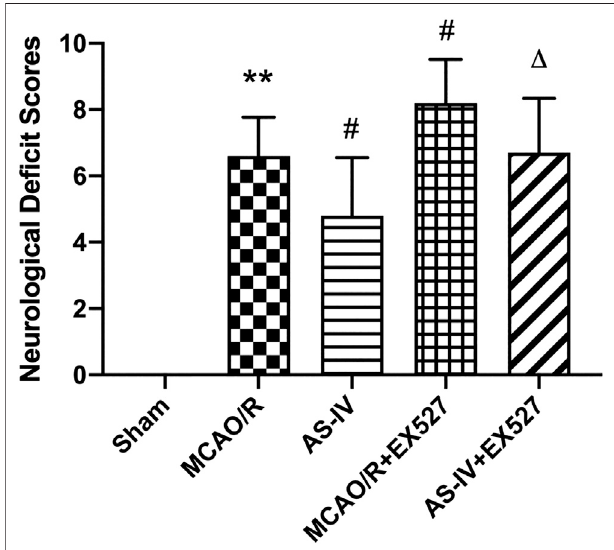
FIGURE 6 | The NDSs in Sham, MCAO/R, AS-IV, MCAO/R + EX527, andAS-IV+EX527groupat7daysafterCIRinjuryinrats(mean ± SD, n (cid:1) 12). ** p < 0.01, compared with the Sham group; # p < 0.05, compared with the MCAO/R group; Δ p < 0.05 compared with the AS-IV group.